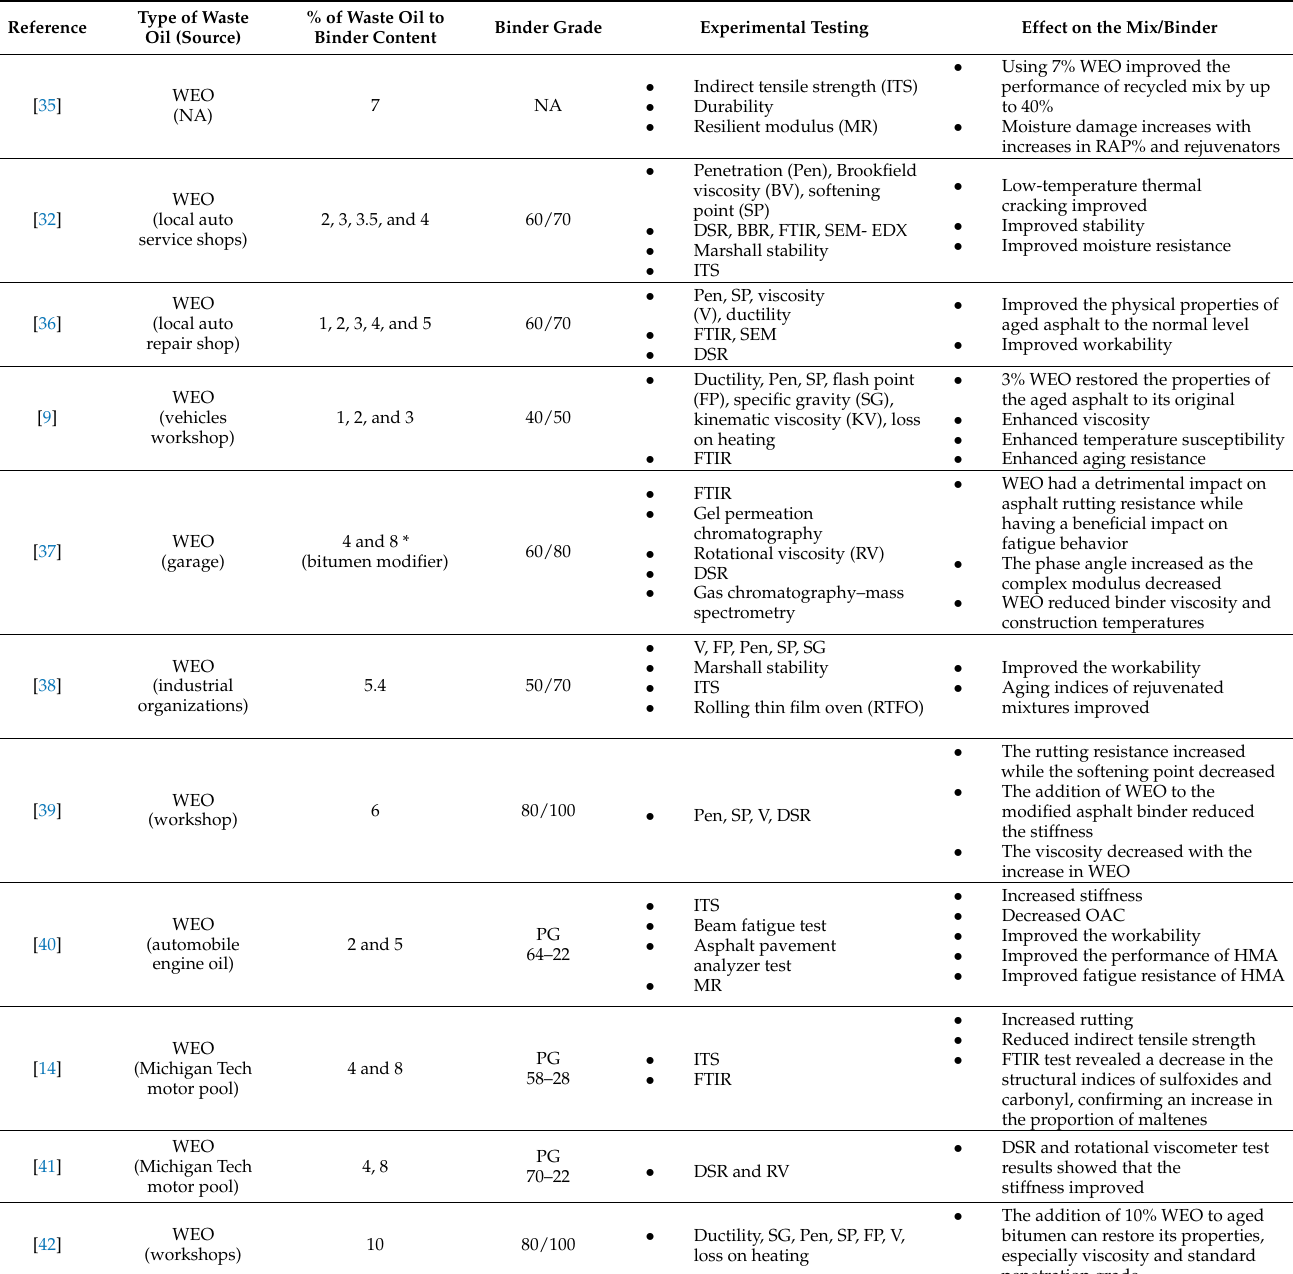
Table 1. Comprehensive review of literature studies on the effects of utilizing waste engine oil on the performance of asphalt binders and/or